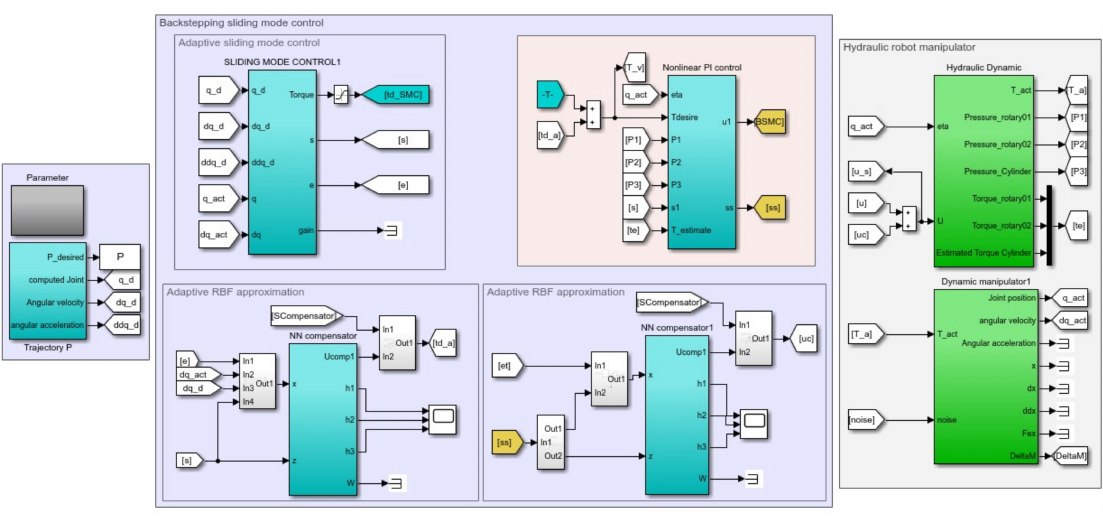
Figure 2. Simulation structure.